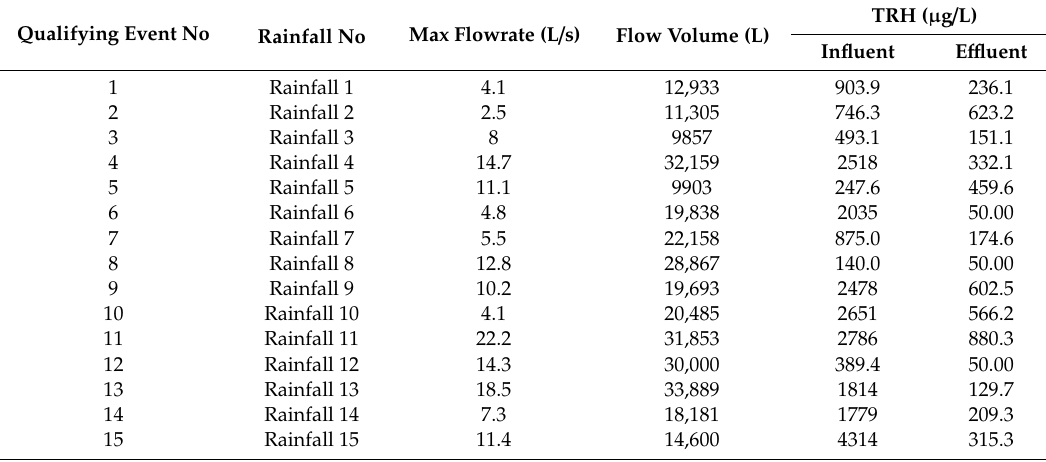
Table A6. TRH influent and e ffl uent results ( LOD = 100 µ g /